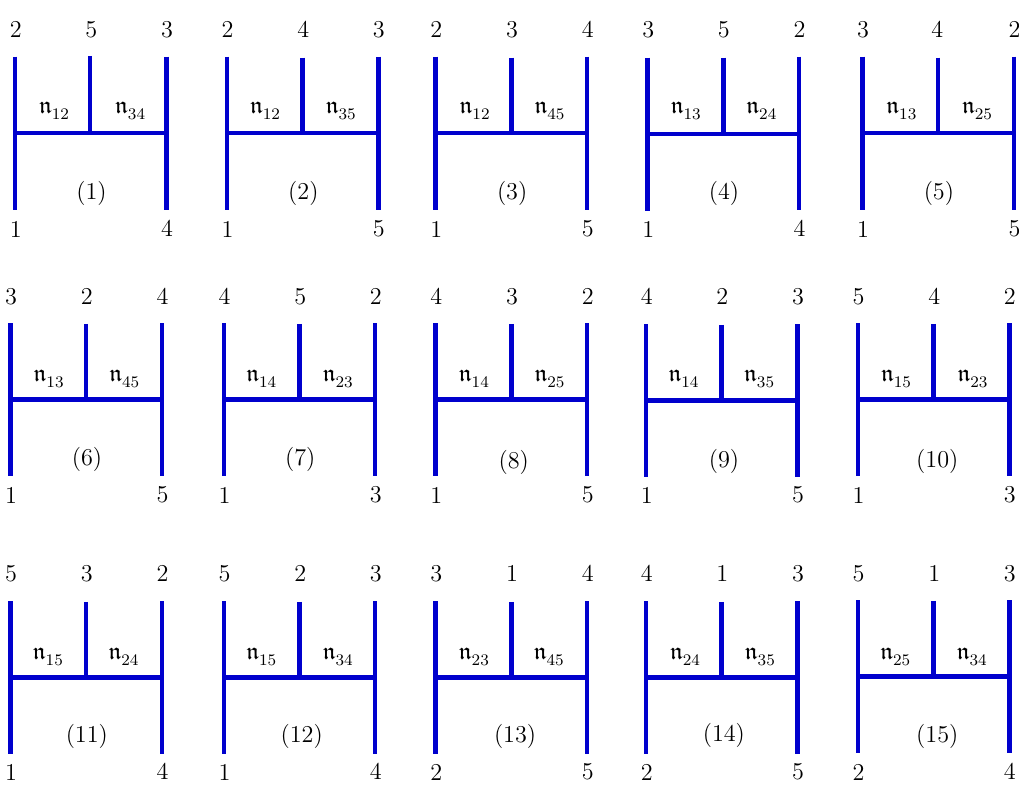
, · · · , n } , and each internal line has its KK index n 1 5